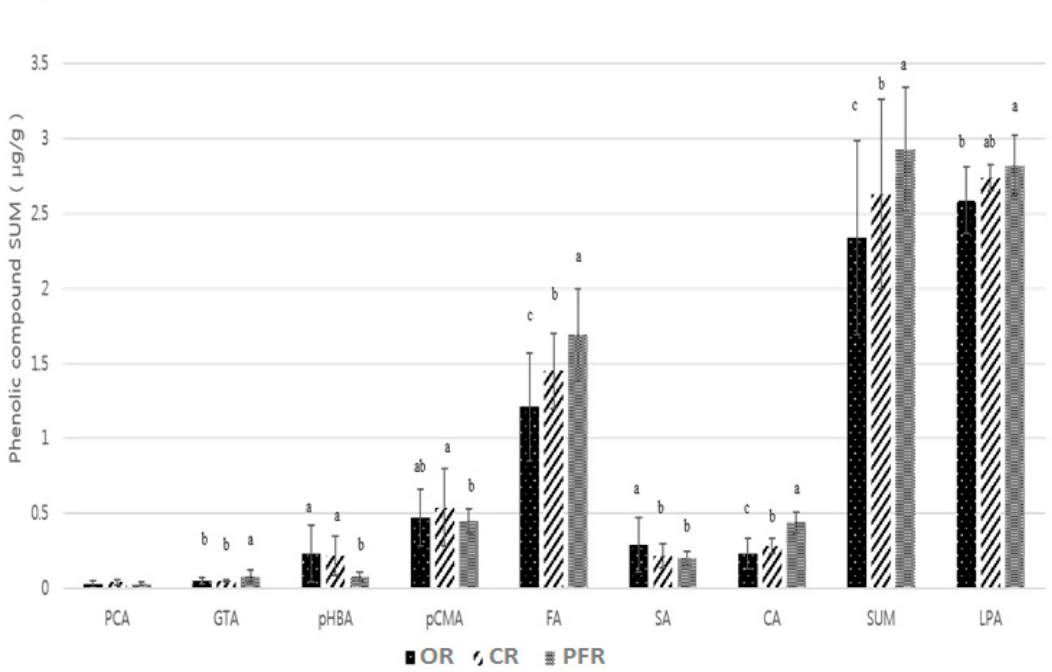
Figure 4 . Distribution of phenolic compounds in OR, CR, and PFR. Letters a–c indicate a significant difference among the three groups ( p < 0.05). Abbreviations: PCA (protocatechuic acid), GTA (gentisic acid), pHBA (p-hydroxybenzoic acid), pCMA (p-coumaric acid), FA (ferulic acid), SA (salicylic acid), CA (caffeic acid), LPA ( L -phenylalanine), and ND (not detected).